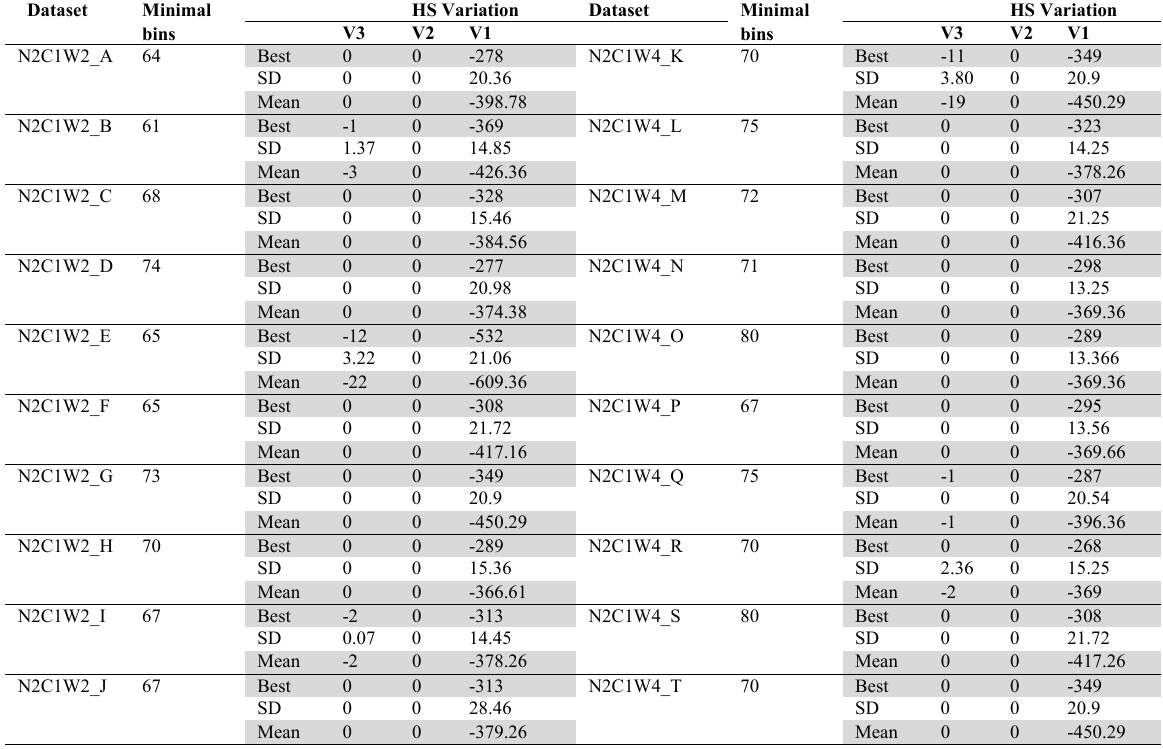
Performance of proposed HS variations for 60 datasets with 100 objects (continued) Dataset